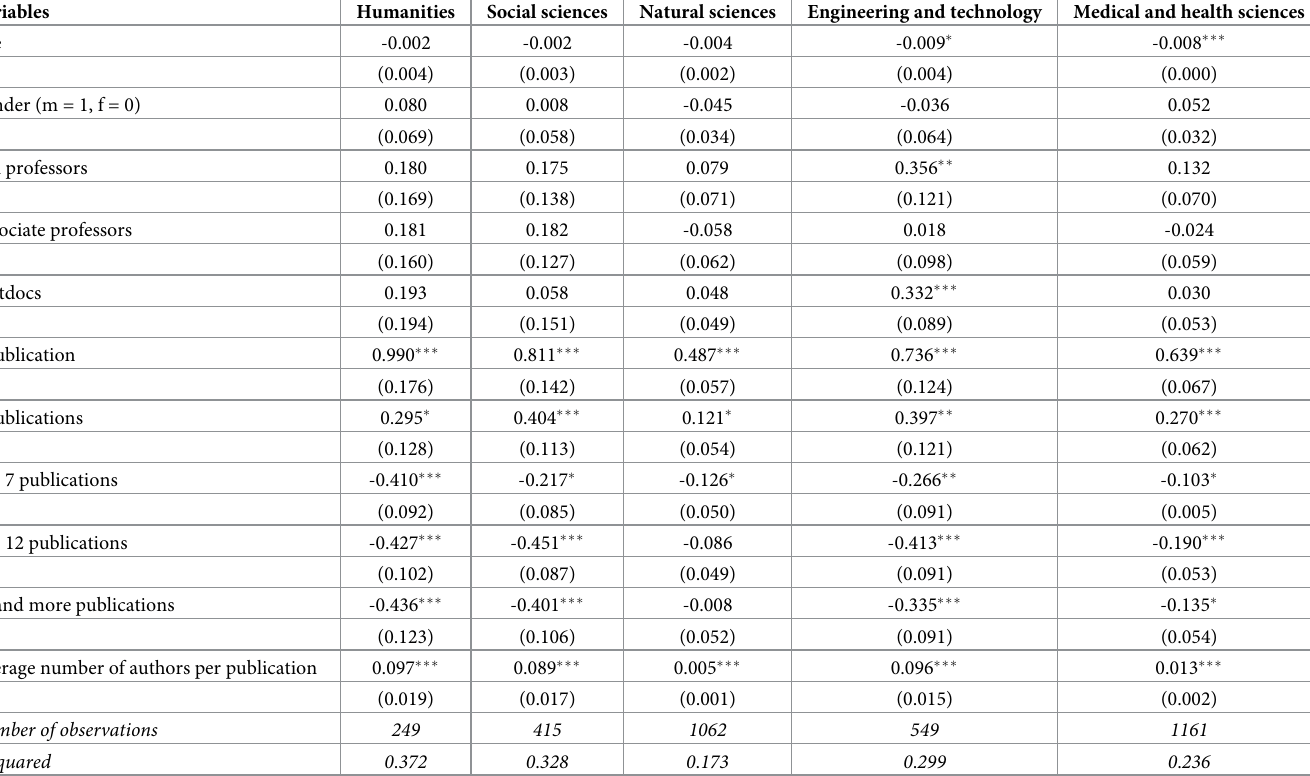
Table 6. Linear regression analysis. Average proportion of publications with international collaboration per researcher (indicator B) and selected variables by major fields. Coefficients and std.